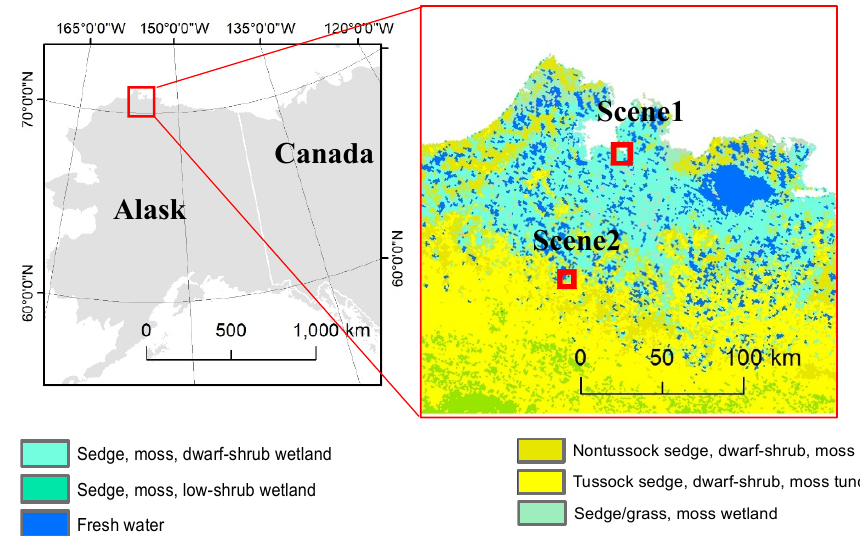
Figure 1. Location of candidate image scenes overlain on the Circumpolar Arctic Vegetation Map (CAVM, [40]).